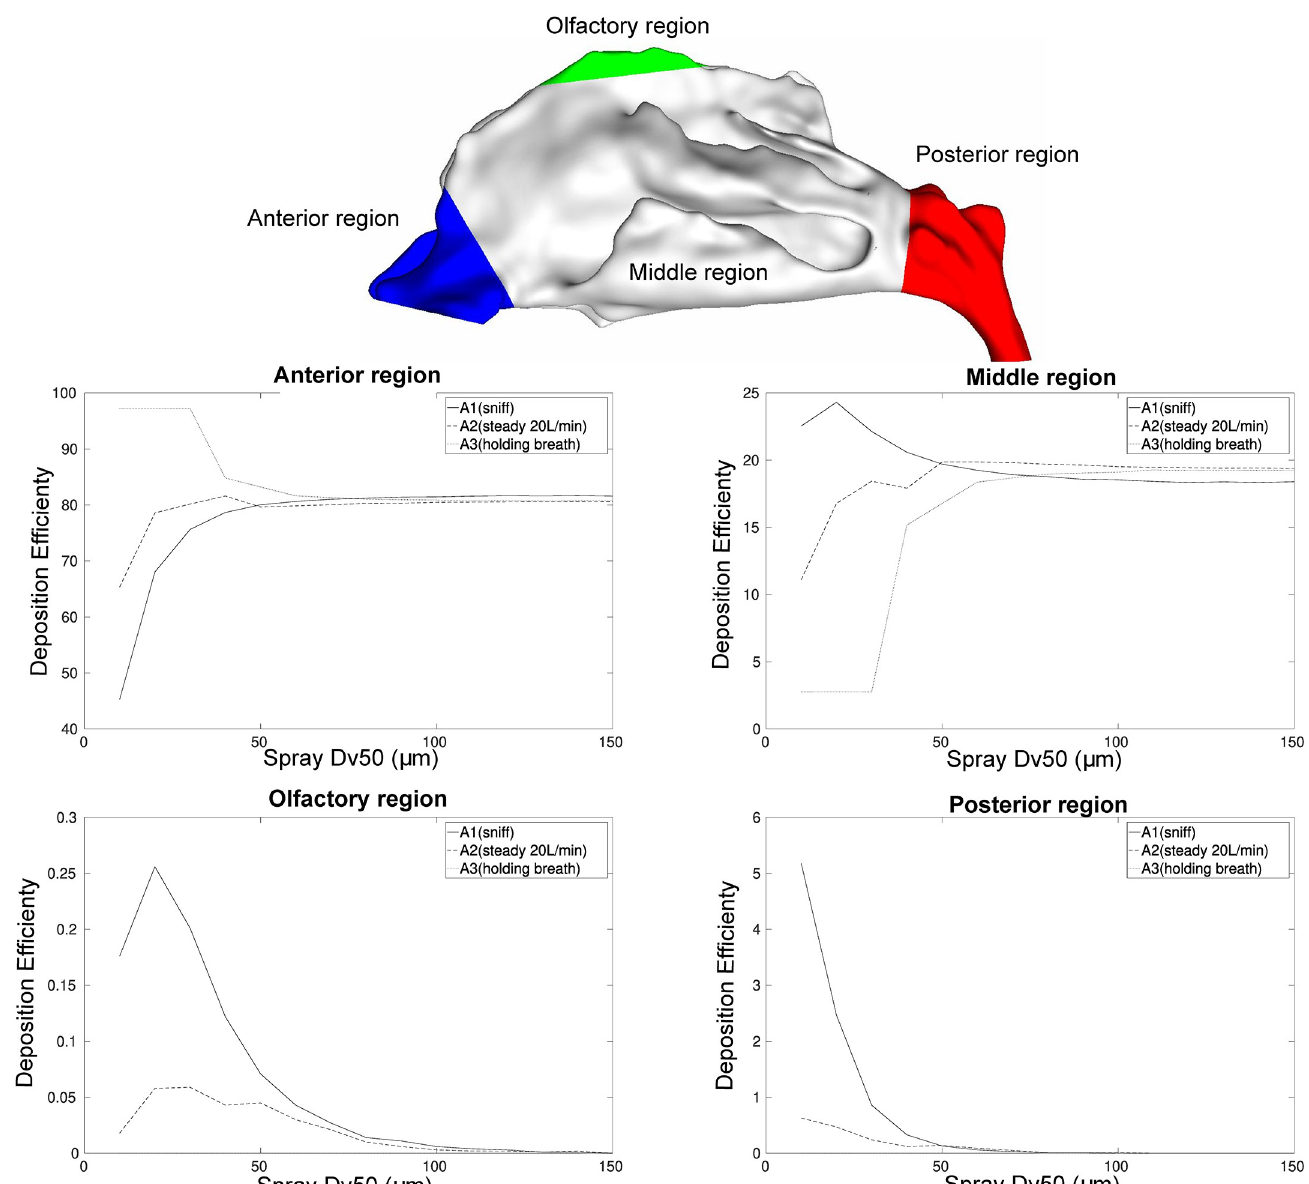
Fig 13. Regional deposition efficiency for the three inhalation conditions in function of particle size distribution Dv 50.